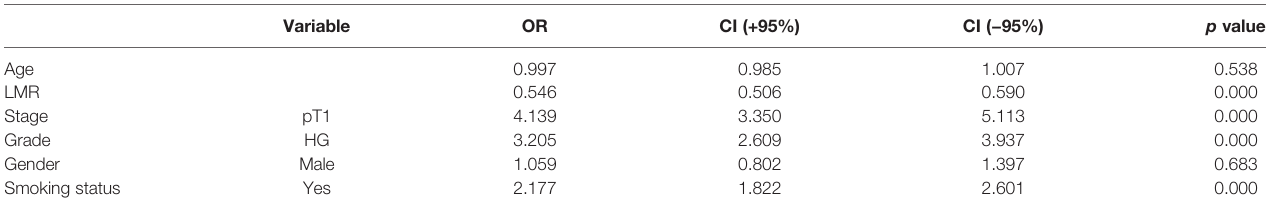
TABLE 2 | Multivariate analysis of second